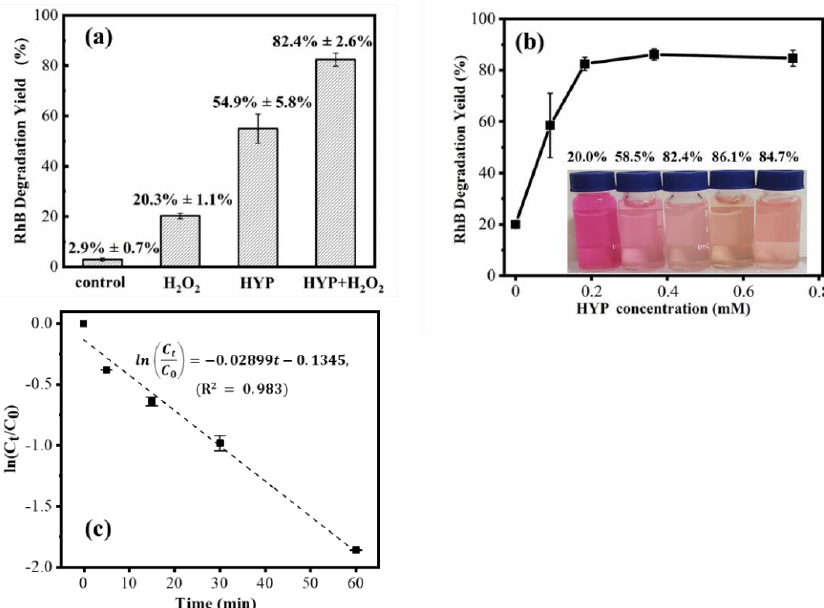
Figure 4. Effect of ( a ) PAOP composition and ( b ) HYPs dosage on the RhB degradation yield after a 60 min reaction. ( c ) Regression of the pseudo-first-order reaction kinetics for RhB degradation in the HYPs/H 2 O 2 PAOP. Table 1. The relative yield of OH· in the PAOP systems.